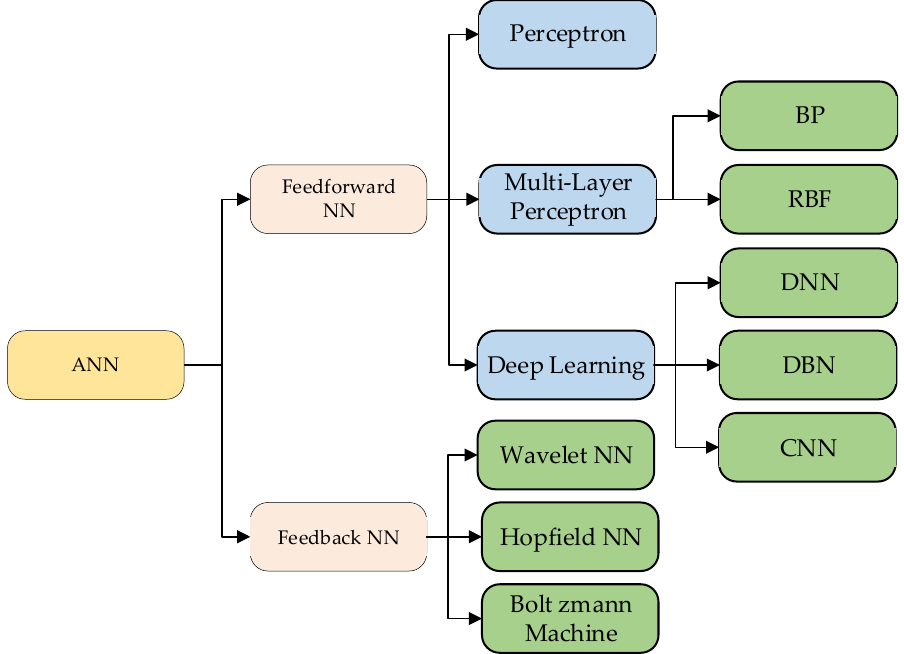
Figure 8. Artificial neural network (ANN) classification. BP, back propagation; RBF, radial basis function; DNN, deep neural network; DBN, deep belief network; CNN, convolution neural net-